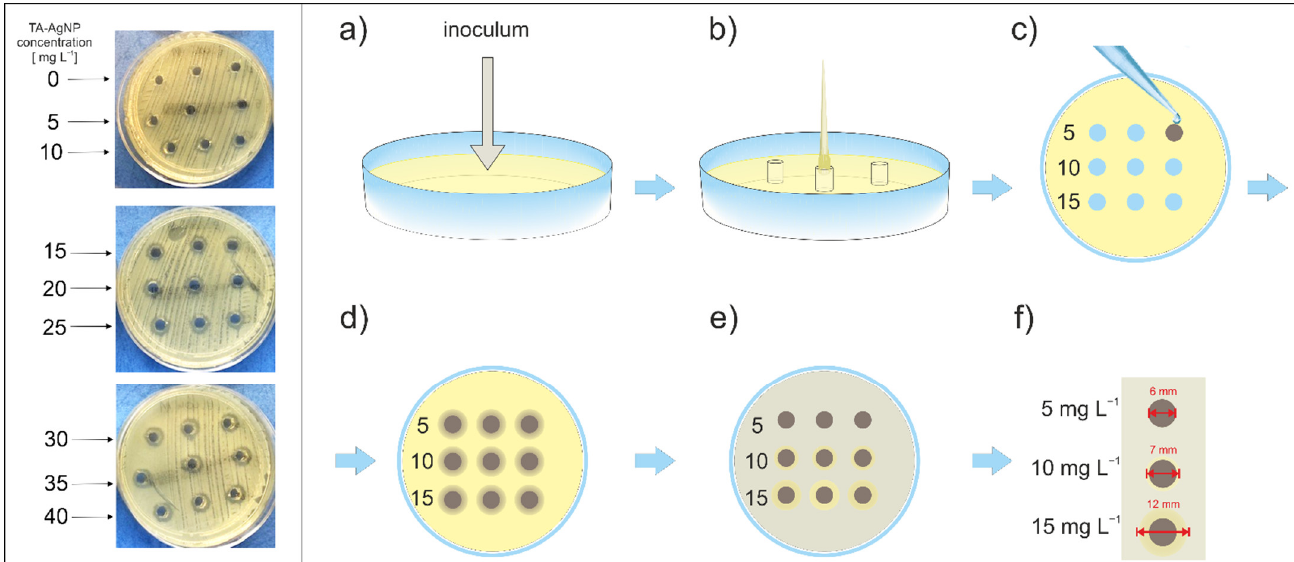
Figure 4. The well diffusion method of MIC approximation used in the study; Left panel: photograph of experiment with E. coli isolate and TA-AgNP in the concentration range of 0–40 mg L −1 (MIC upper limit: 15 mg L −1 ) Right panel: schematic representation of the experimental protocol: ( a ) inoculation with isolate saline suspension 10 6 CFU mL −1 ; ( b ) wells in Müller–Hintonagar were cut with a sterile pipette tip; ( c ) 100 μL TA-AgNP suspension was added into each well in a concentration range of 5–100 mg L −1 , in the figure triplicates of 5, 10 and 15 mg L −1 ( d ) diffusion of TA-AgNP in the Müller–Hinton agar during 4 h incubation at 4 °C; low temperature slowed down the bacteria growth, ( e ) bacteria growth over Müller–Hinton agar during 18 h incubation at 37 °C; ( f ) measurement of a zone of inhibition of bacterial growth and estimation of MIC (here MIC upper limit 10 mg L −1 ) Colors used in the figure: yellow—Müller–Hinton agar, brown—TA-AgNPs suspension added to the wells ( c ) and diffusing in the agar ( e ), grey—bacterial growth. Table 1. The upper limit of minimal inhibitory concentration (MIC) of TA-AgNPs for the reference strains and clinical isolates (mg L −1 ). MIC values did not have a normal distribution; therefore, the median was used as a measure of central tendency and the interquartile range was used as a measure of statistical dispersion. Higher MIC values indicate a lower sensitivity to TA-AgNPs.